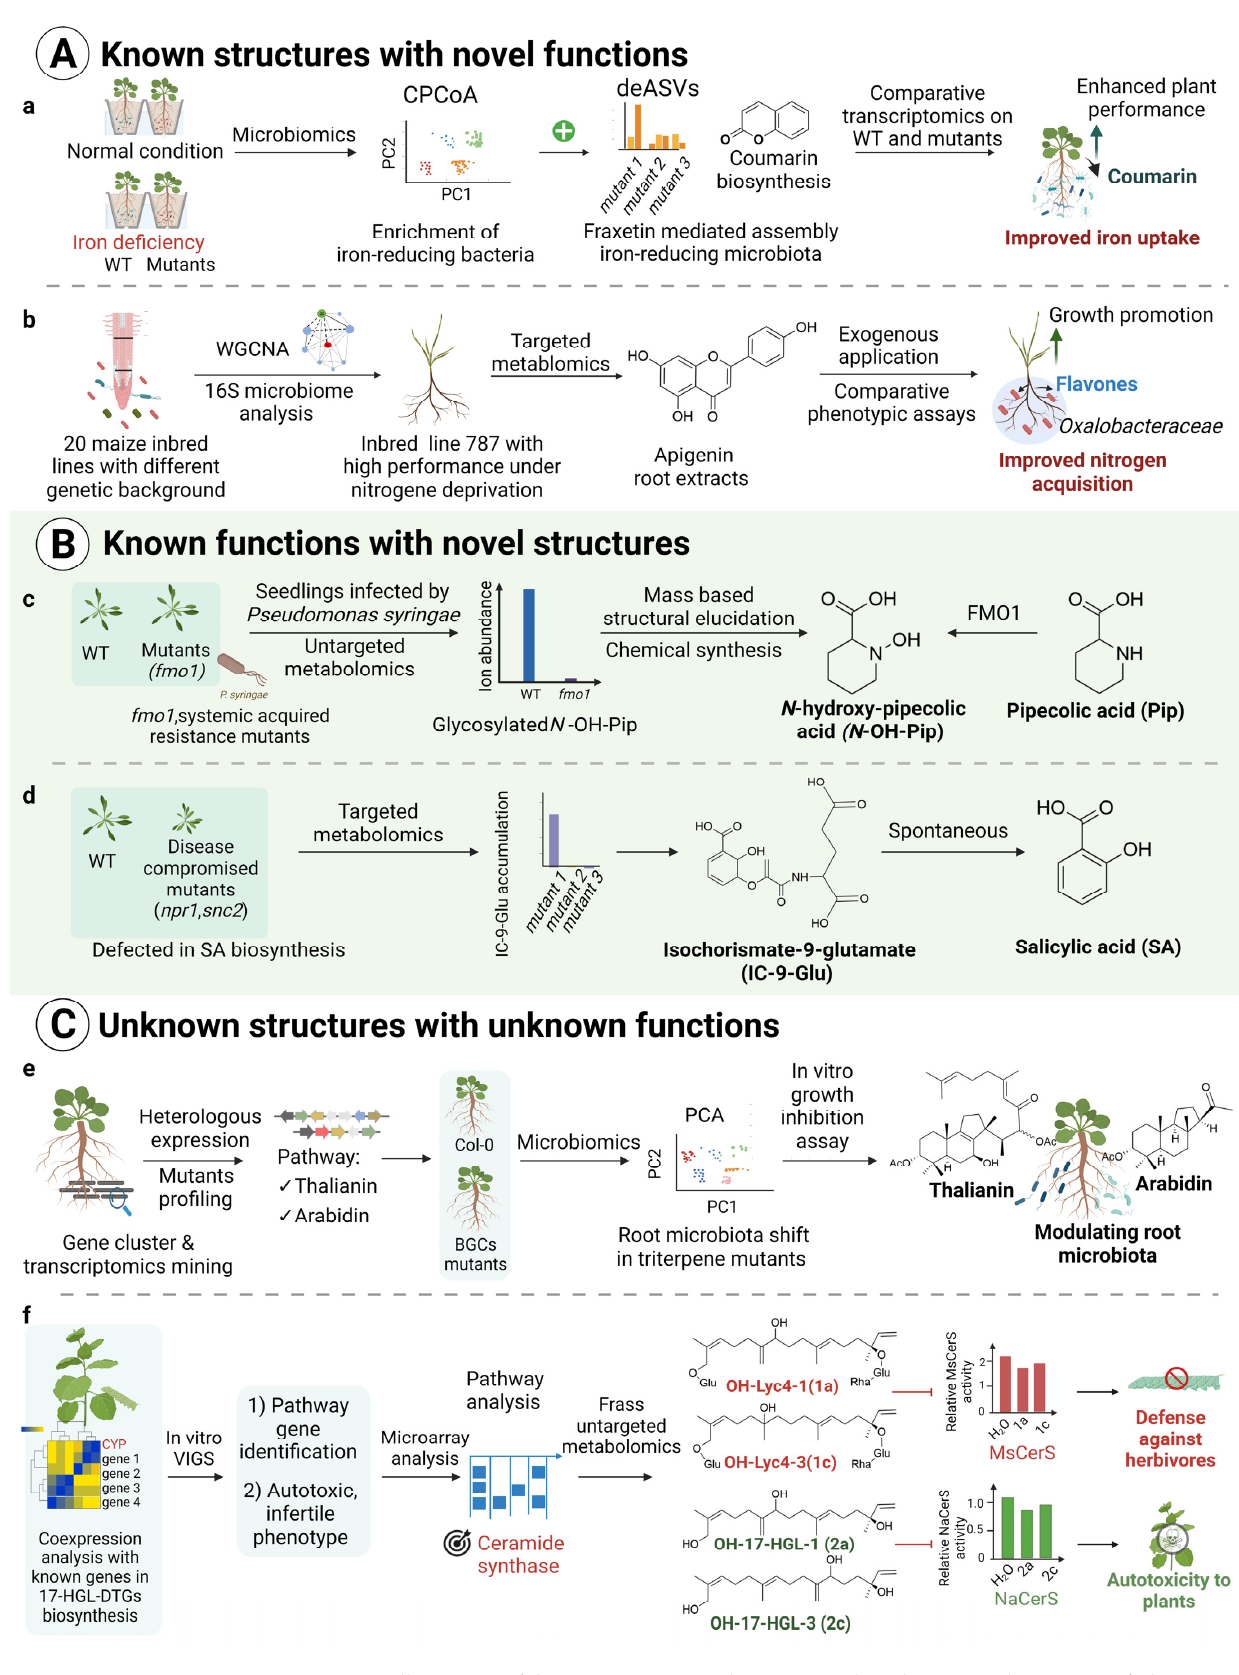
Figure 2. Illustration of the various omics techniques employed in recent discoveries of plant signaling metabolites. The overall experimental designs and key techniques applied for discovering